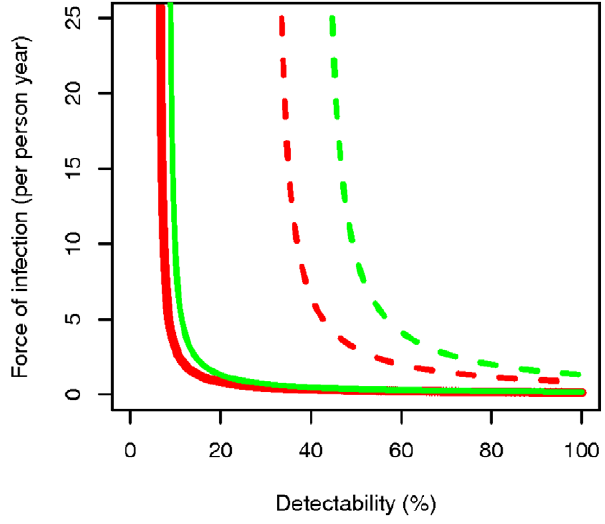
Figure 3. Force of infection against detectability of parasitae- mia. Force of infection ( l 0 : new infections prior to any treatment per person year) against the probability of detecting an existing parasitaemic infection (in a cross sectional survey) at 5% measured prevalence (solid lines) and 25% measured prevalence (dashed lines), with a treatment probability of new infections of 20% (red lines) and 40% (green lines), with an average natural parasitaemia duration of 200 days.